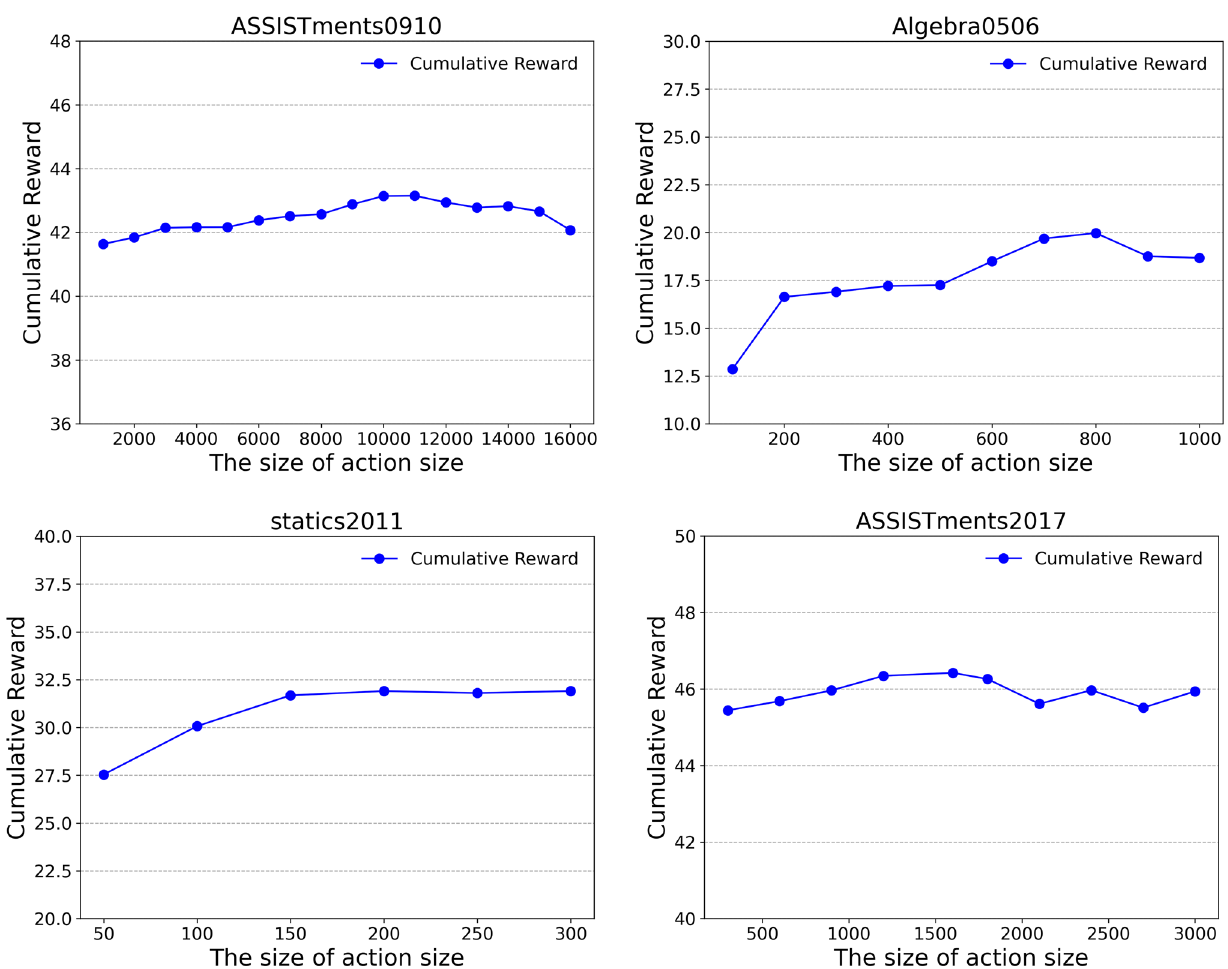
Fig. 15 Effect of the size of action space for different